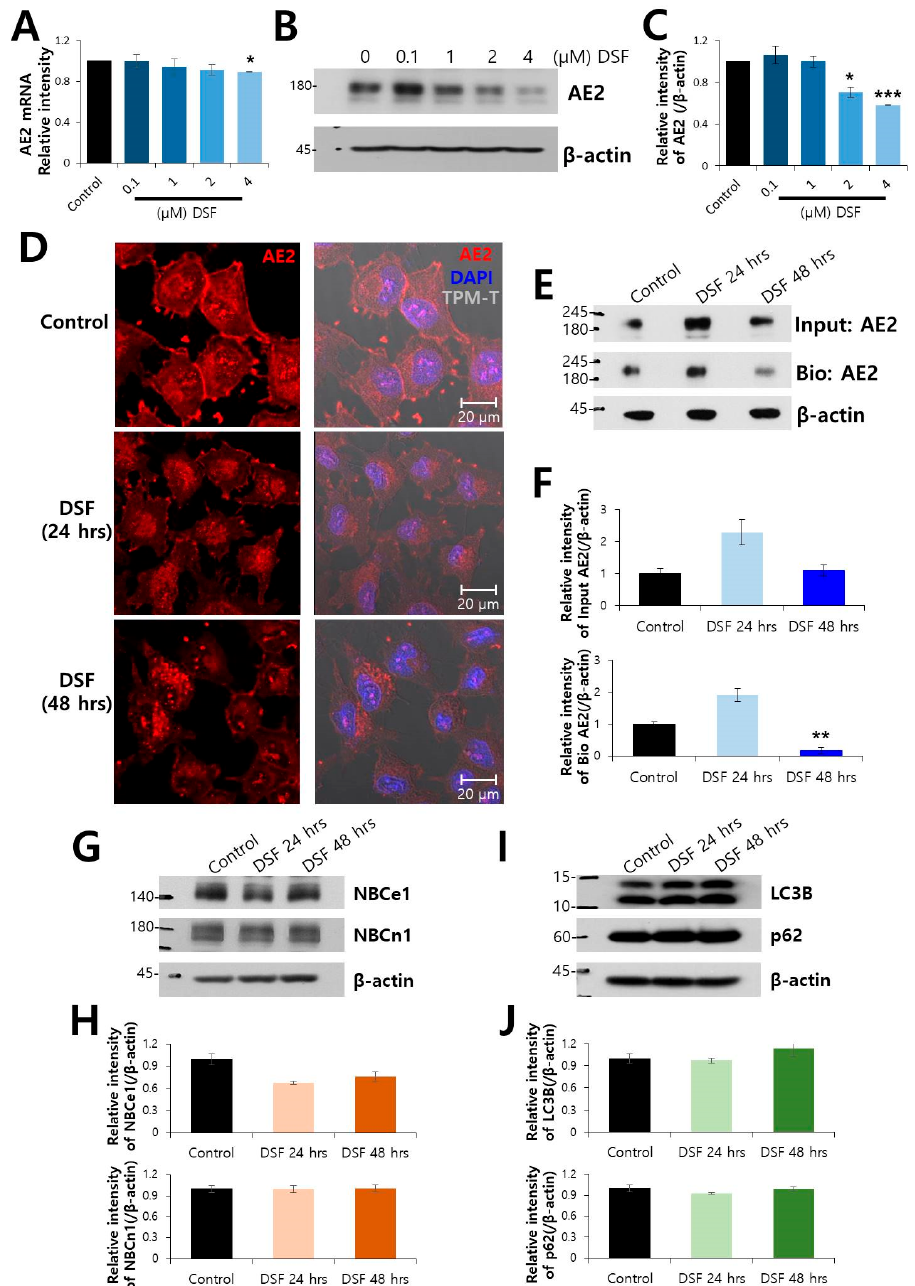
Figure 2. Surface protein expression of AE2 protein was decreased by DSF treatment. ( A ) Analysis of AE2 mRNA expression at rising concentrations from 0.1–4 µ M DSF for 48 h (n = 5). ( B ) Protein expression of AE2 at indicated DSF concentration. ( C ) Analysis of relative AE2 intensity (n = 3, * p < 0.05, *** p < 0.001). ( D ) Immunostained images of AE2 (red), nucleus (DAPI, blue) and merge of cell morphology (TPM-T, gray) with and without DSF treatment. The scale bars represent 20 µ m. ( E ) The surface expression of AE2 after treatment with 2 µ M DSF. The β -actin and input AE2 blots were used as loading controls. ( F ) Analysis of relative intensity of AE2 for input and biotinylated (Bio) blot. Bars represent mean ± SEM (n = 3, ** p < 0.01). ( G ) Protein expressions of NBCe1 and NBCn1. ( H ) Analysis of relative intensity of NBCe1 and NBCn1 blots. Bars represent mean ± SEM. ( I ) Protein expressions of LC3B and p62. The β -actin blot was used as a loading control. ( J ) Analysis of relative intensity of LC3B and p62 blots. Bars represent mean ±